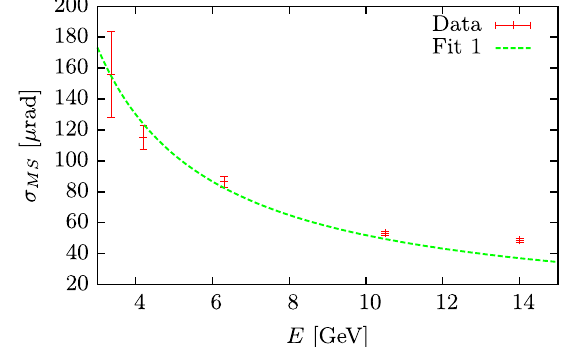
FIG. 12. A fit to the 10.5 GeV experimental data at half the crystal bending angle.